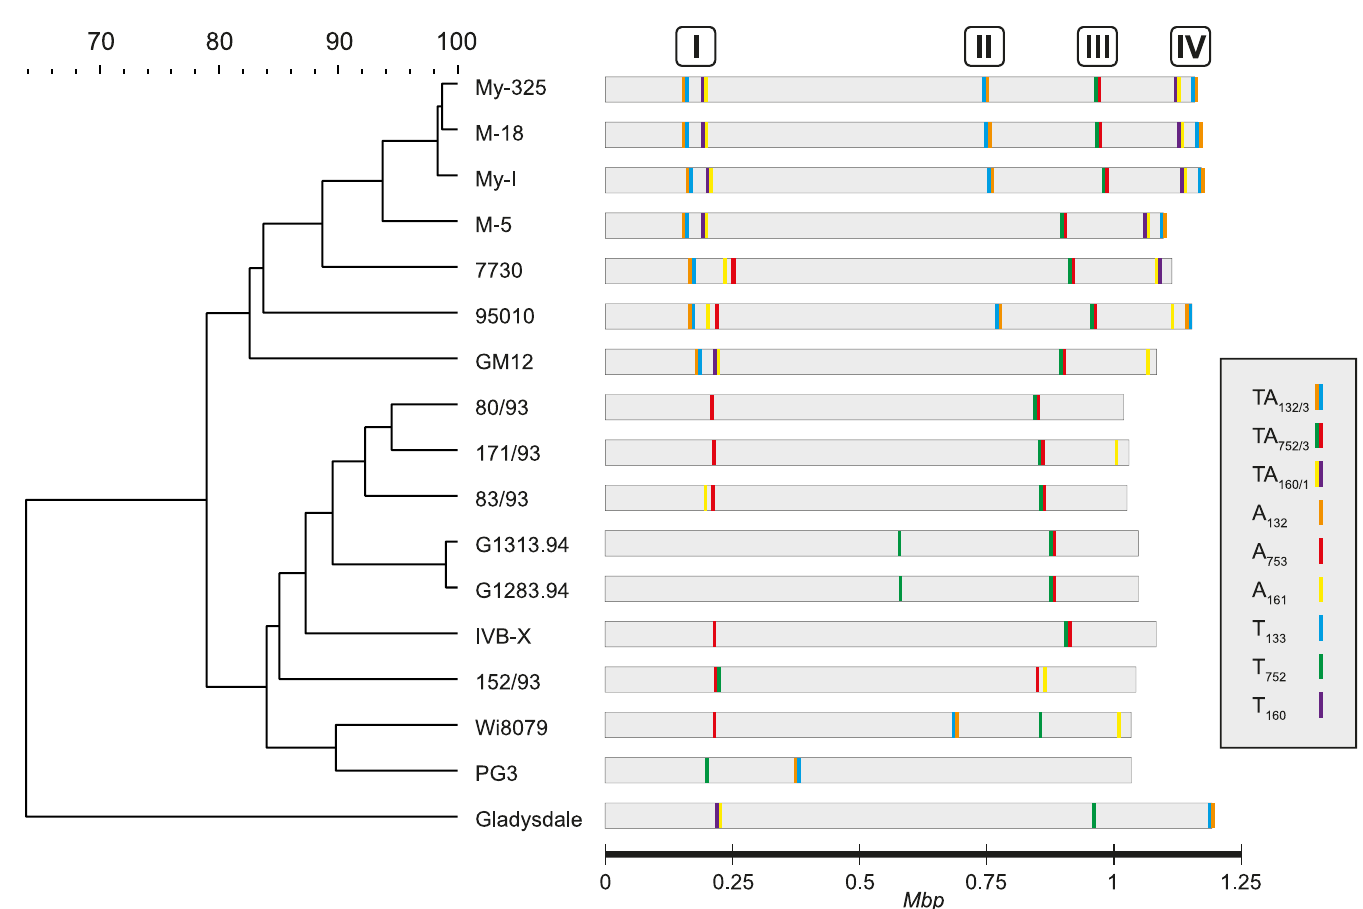
Fig 1. Cartoon displaying the genomic localization of candidate TA systems of M . mycoides subsp. capri GM12 in different M . mycoides subsp. capri strains and in one M . mycoides subsp. mycoides strain. Tree displaying the phylogenetic relationship of the strains based on whole genome sequence data is presented (left). M . mycoides subsp. mycoides strain Gladysdale was used as an outgroup. The tree was constructed in Bionumerics 8.0 using the comparative genomics tool applying standard parameters. The genomic locations of the different copies of the three candidate TA systems investigated in this study are depicted with vertical lines of different colors as detailed in the figure legend (right). The four main genomic regions harboring candidates TA modules are indicated as TA regions I to IV.